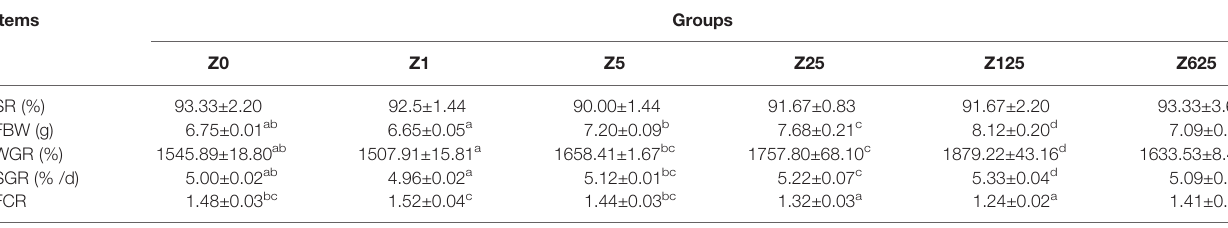
TABLE 3 | Growth performance and feed utilization of L. vannamei fed the experimental diets for 8 weeks.